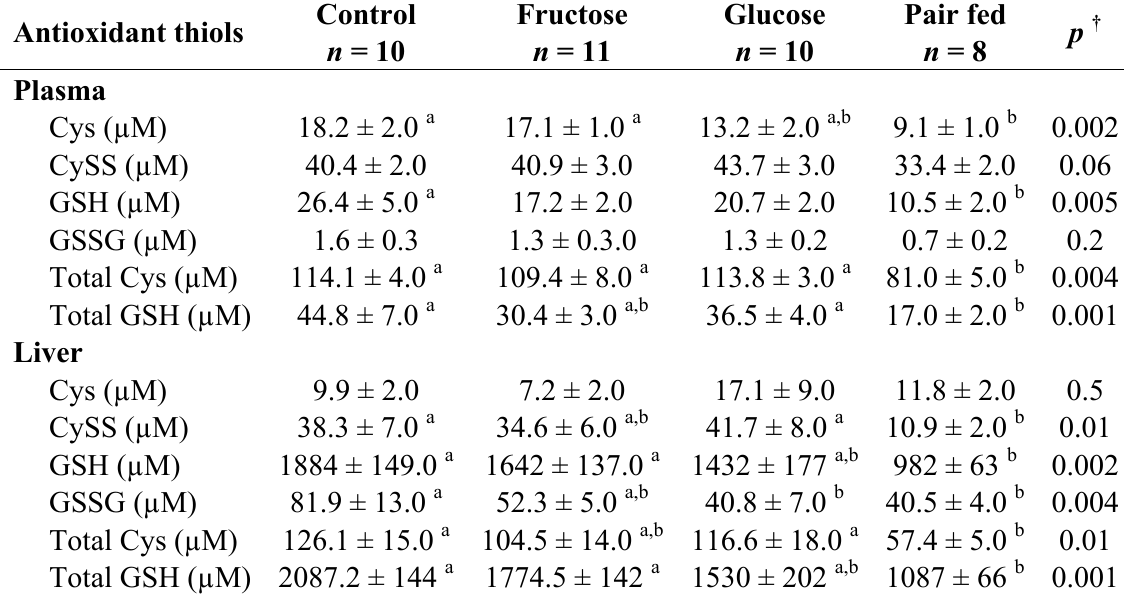
Table 2. High Performance Liquid Chromatography data of plasma and liver thiols #